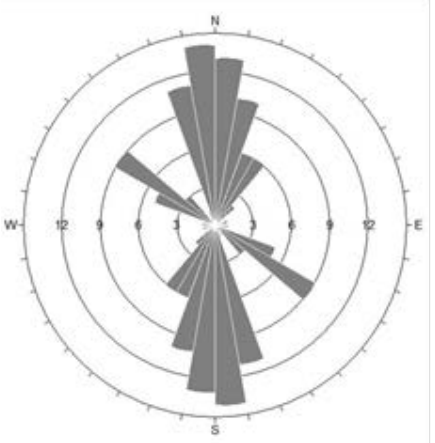
Fig.4. Rose diagram (10◦ classes) shows the lineament distribution in the study